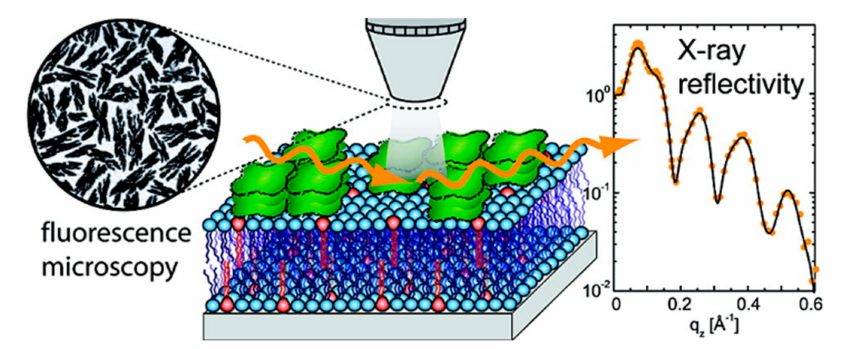
Schematic representation of supported lipid bilayer with proteins at the surface. X-ray reflectivity along with fluorescence microscopy characterized the structure and fluidity of protein layers. (Reproduced with permission from [149], copyright 2007 American Chemical